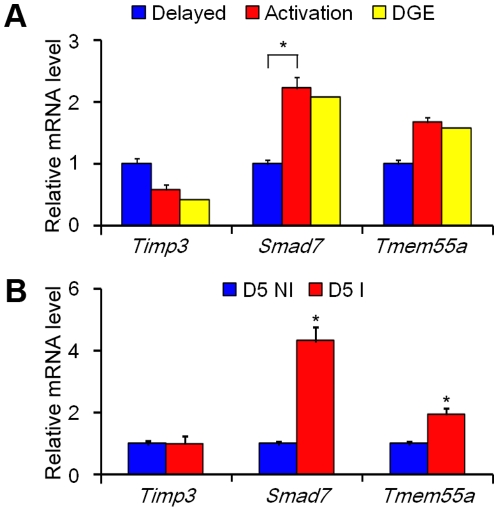
qRT-PCR analysis of the mRNA level of three target genes of let-7a-5C in mouse uteri.(A) The mRNA level of each gene in mouse uterus under delayed implantation and activation. The data from SAGE-Illumina sequencing (DGE) in mouse uterus under delayed implantation and activation were marked in yellow color; (B) The mRNA level of each gene in mouse uterus on day 5 of pregnancy at implantation sites (D5 I) and non-implantation sites (D5 NI).